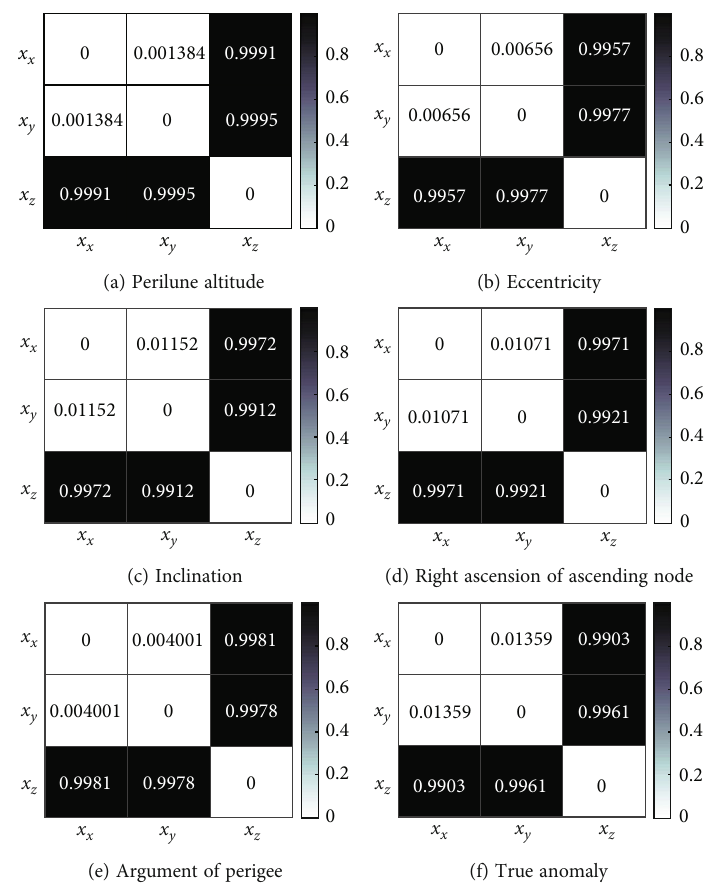
Figure 7: Sensitivity index for combinations of position parameters.